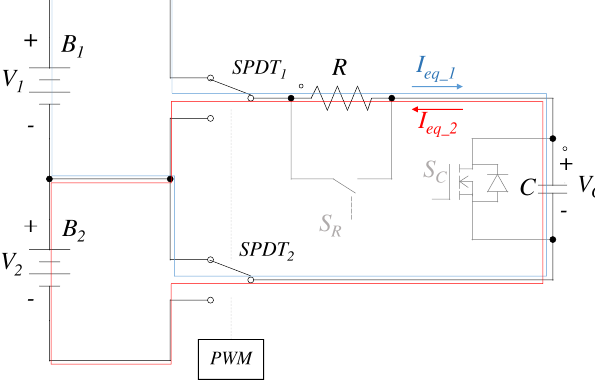
Figure 7. RC-based mode of